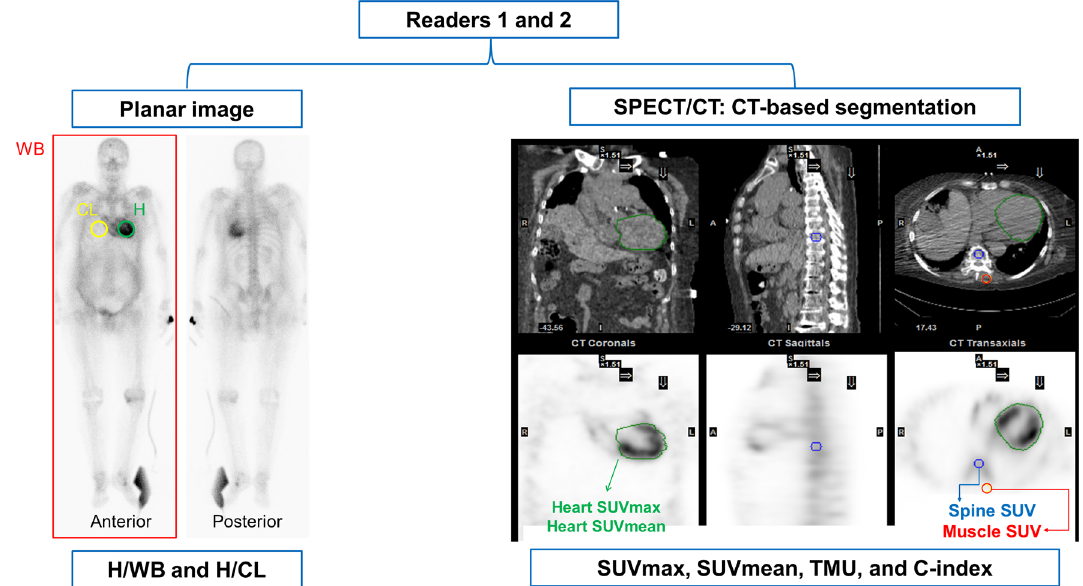
Figure 6. Study scheme and analysis methods of [ 99m Tc]Tc-DPD images. Quantitative indexes on planar image (H/WB and H/CL) and SPECT/CT (SUVmax, SUVmean, TMU, and C-index) were calculated and interobserver agreement was assessed between the two